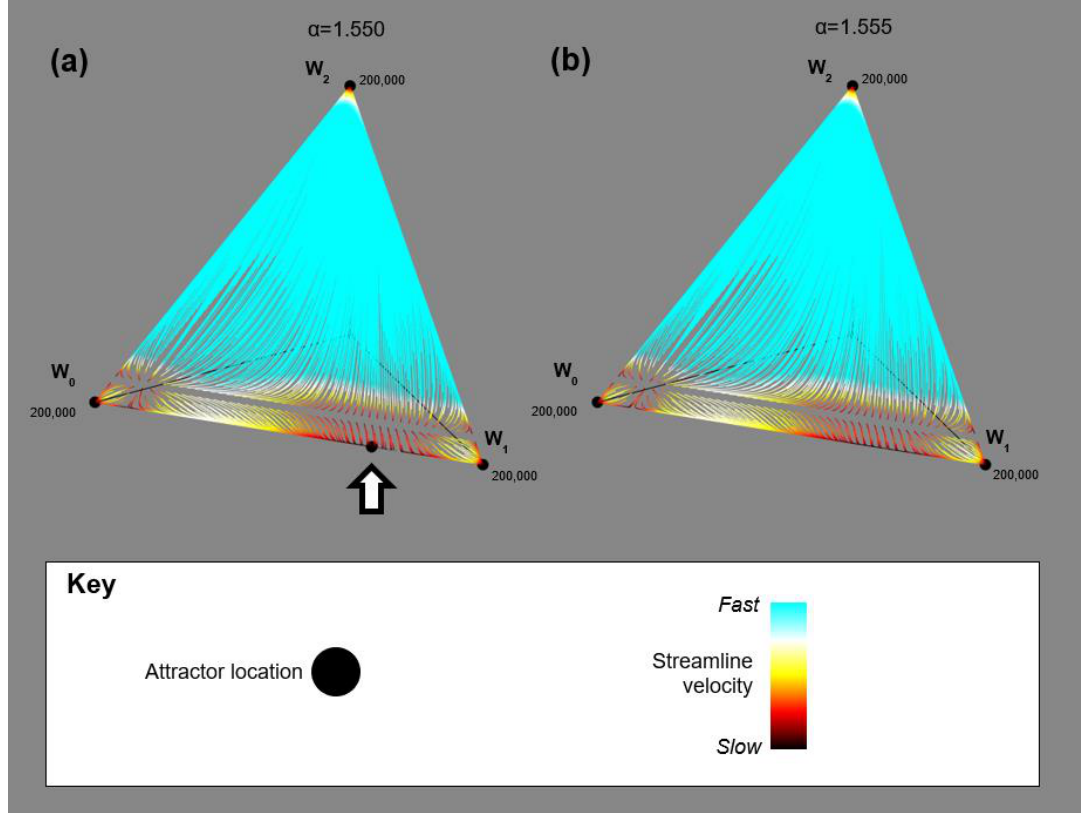
Figure 4. Streamlines with velocity colour-coded for state space of region R2 across two parameter sets. This demonstrates how a slow subpart of state space can transition into a new stable attractor. ( a ) Fourth attractor is present, indicated by white arrow; and ( b ) the fourth attractor is absent. Note: β = b = 0.3.